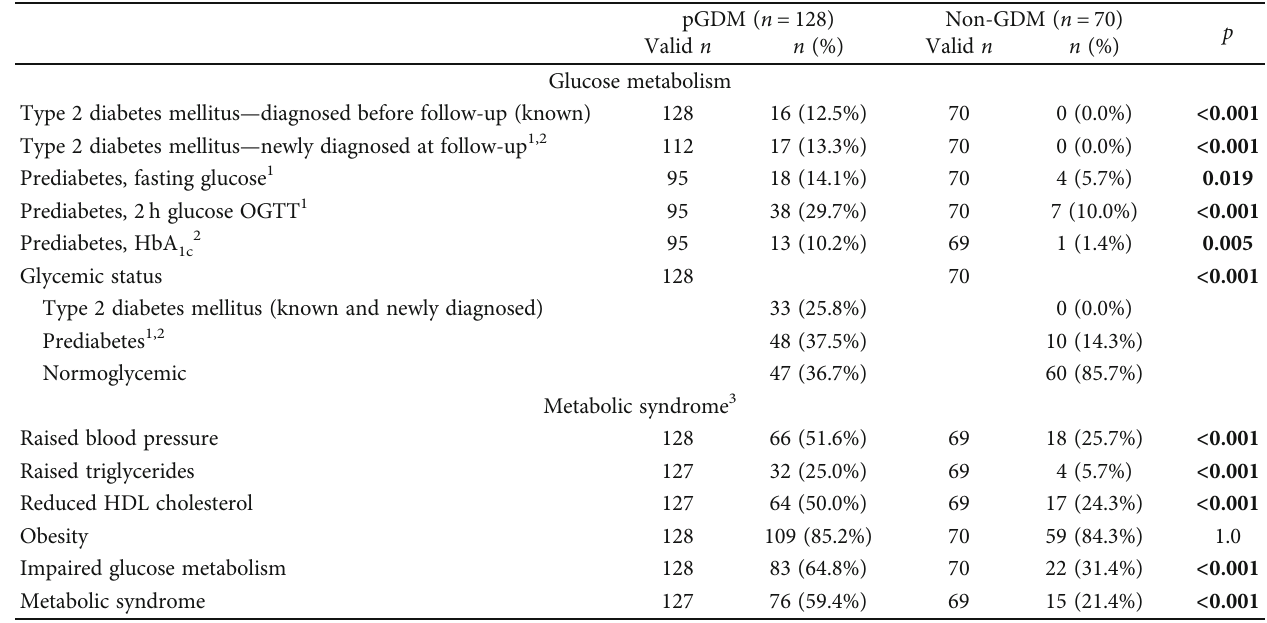
Table 2: Comparison of rates of impaired glucose metabolism and components of the metabolic syndrome between women with previous gestational diabetes (pGDM) and controls